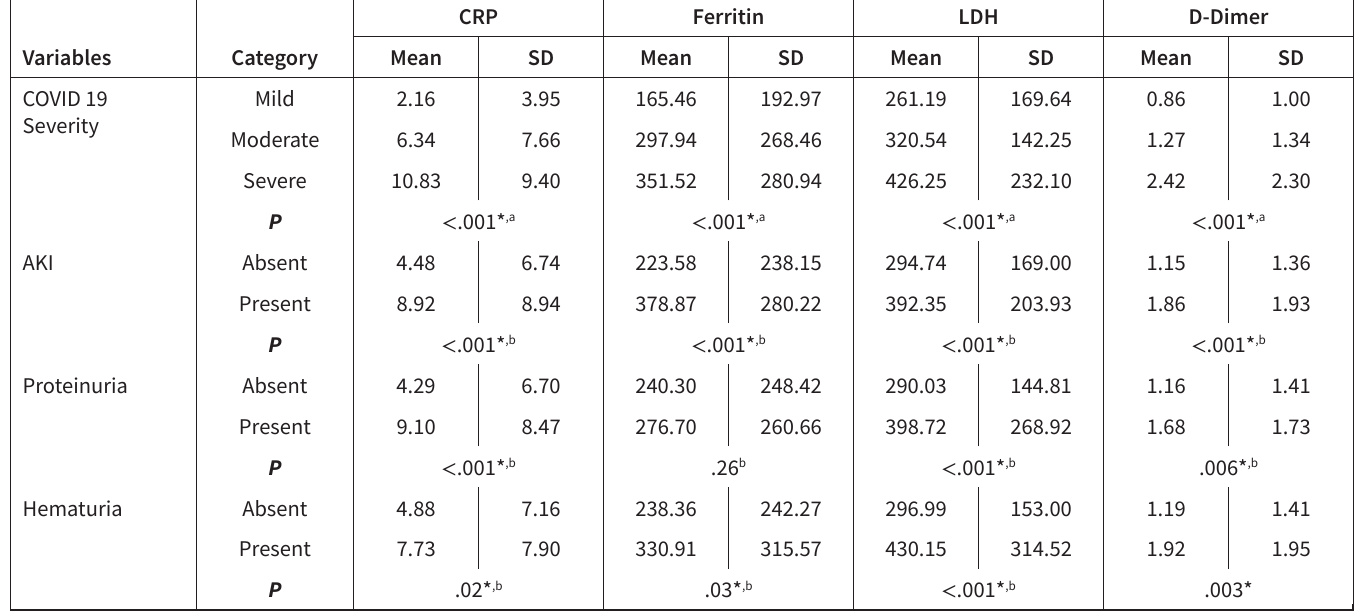
Table 8. Comparison of Mean Values of Inflammatory Markers (CRP, Ferritin), LDH, d -Dimer with Clinical Severity of COVID- 19, AKI, Proteinuria, and Hematuria